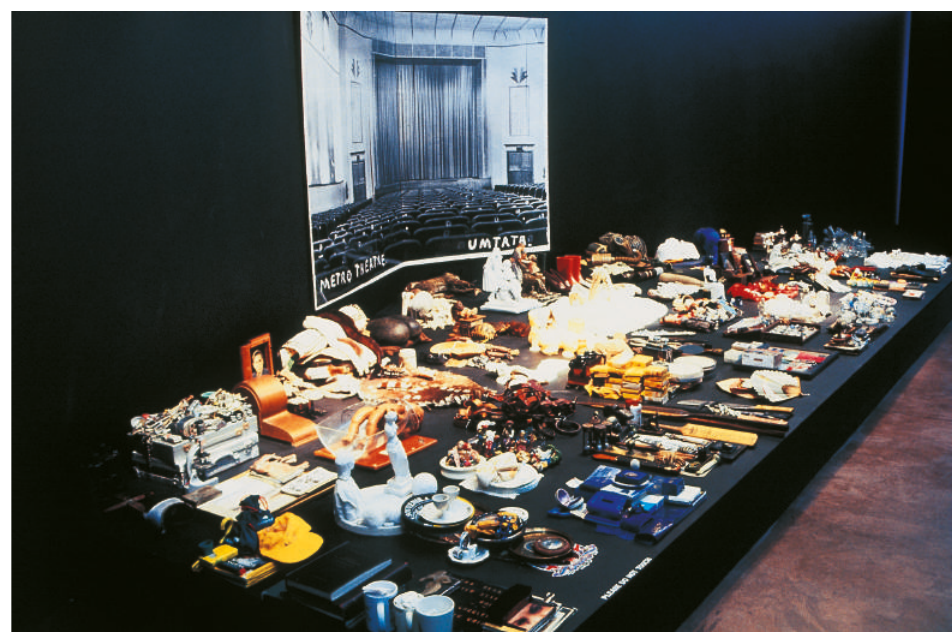
Penny Siopis, Reconnaissance (1900-1997), 1997. Installation of found objects, dimensions variable (photo: courtesy Penny Siopis and Stevenson Gallery, Cape Town).